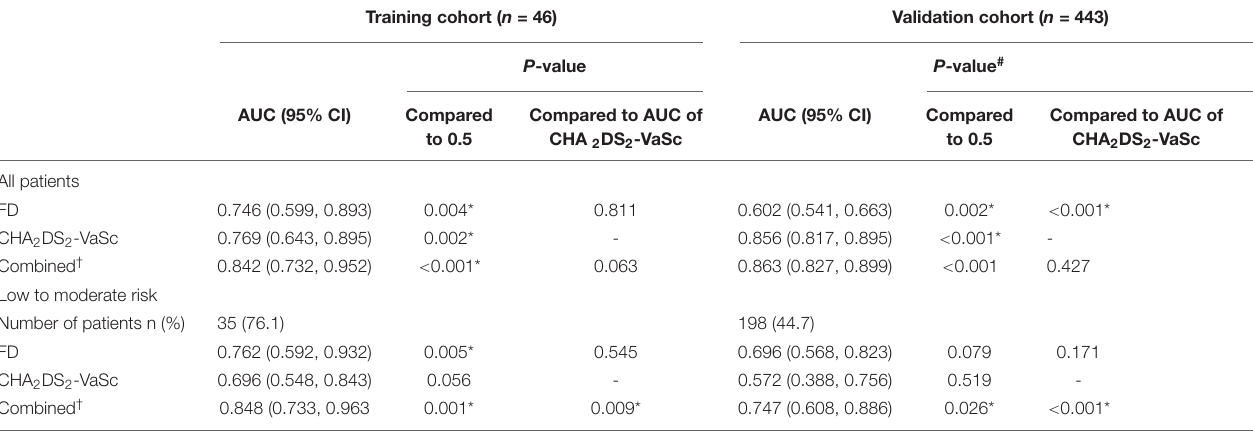
TABLE 3 | ROC analysis of patients with AF in the training and validation